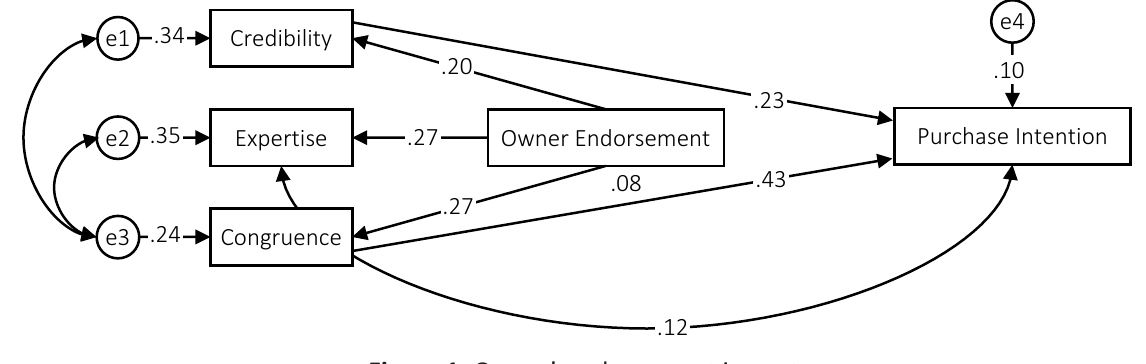
Figure 1. Owner’sendorsement